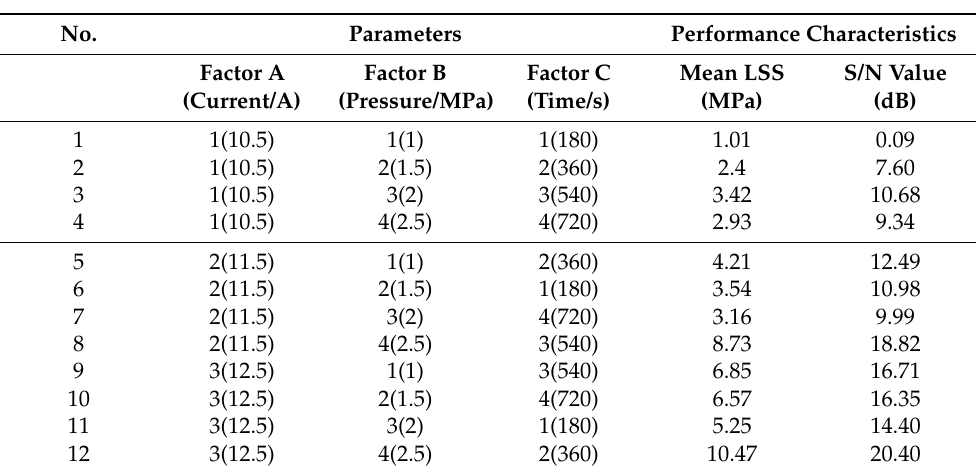
Table 5. Input variables and experimental